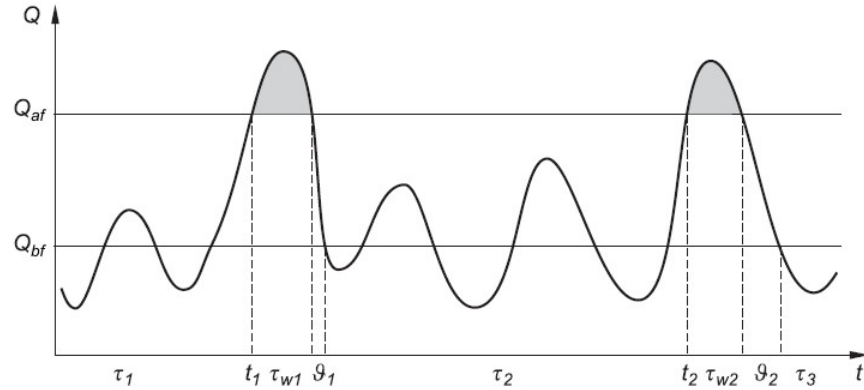
Figure 1. Hydrograph with periods of reliable hydrological system operation ( τ i ), moments of failure occurrence ( t i ), duration of failure ( τ wi ) tied to the duration of system renewal ( ϑ i ). Q bf is the boundary flow of the river flood, often accepted as the minimal flow of annual maximum floods over the observation period, Q af —maximum flow not causing flood losses, often accepted as the mean flow of annual maximum floods for the observation period or Q max,T=2 year return period ( Q max, p =50% ). For hydrological systems, the object reliability function, 𝑅(𝑡) , is a well-characterized measure that represents the probability of meeting the requirement of proper operation.